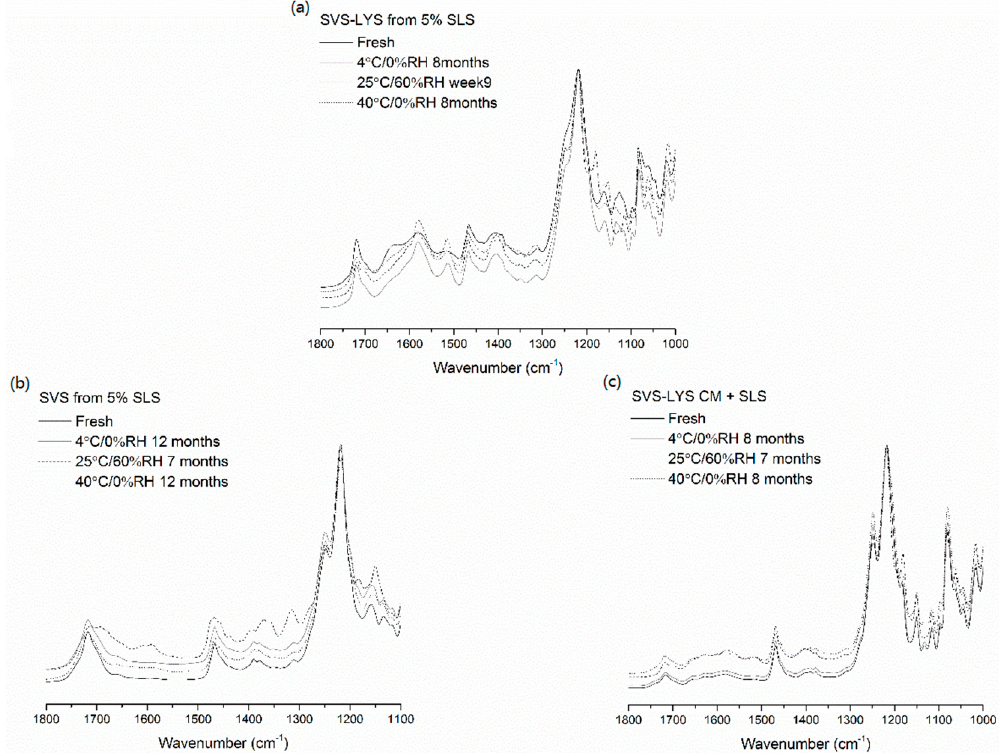
Figure 7. FTIR-spectra of the spray-dried powders after storage under different conditions: ( a ) SVS-LYS spray-dried from 5% SLS; ( b ) SVS spray-dried from 5% SLS; ( c ) SVS spray-dried from 5% SLS and SVS-LYS CM + 5% SLS.